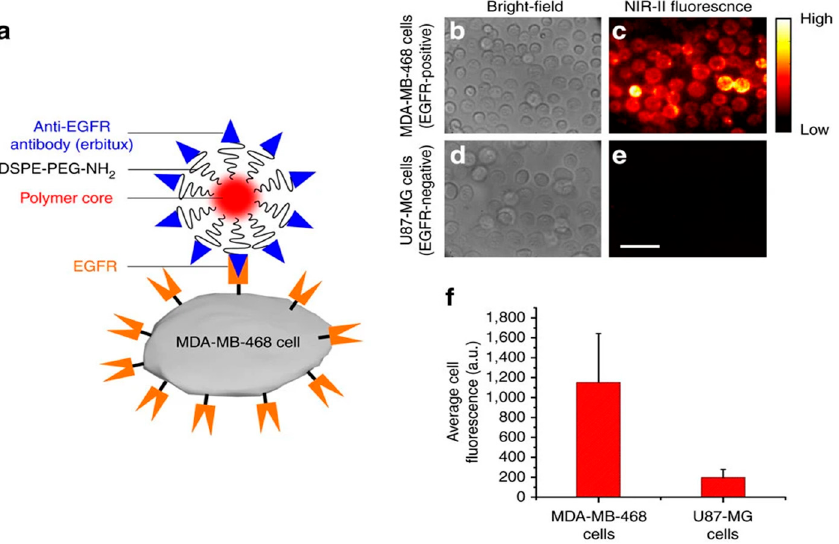
Figure 6. ( a ) Schematic illustration showing the structure of pDA ‐ PEG ‐ Erbitux bioconjugate, where the anti ‐ EGFR antibody (Erbitux) selectively targets EGFR on the cell membrane of an MDA ‐ MB ‐ 468 cell. White ‐ light ( b ) and NIR ‐ II ( c ) fluorescence images of EGFR ‐ positive MDA ‐ MB ‐ 468 cells incubated with the pDA ‐ PEG ‐ Erbitux bioconjugate, showing positive staining of cells. White ‐ light ( d ) and NIR ‐ II ( e ) fluorescence images of EGFR ‐ negative U87 ‐ MG cells incubated with the pDA ‐ PEG ‐ Erbitux bioconjugate, without evident staining of the cells. The scale bar is 40 μ m. ( f ) Average NIR ‐ II fluorescence of EGFR ‐ positive MDA ‐ MB ‐ 468 cells and negative U87 ‐ MG cells, showing a positive/negative ratio of ~5.8. The error bars in f are the s.d. of average fluorescence intensity from 20 cells in each NIR ‐ II fluorescence image. Reprinted with permission from [173]. Copyright 2014 Springer Nature.